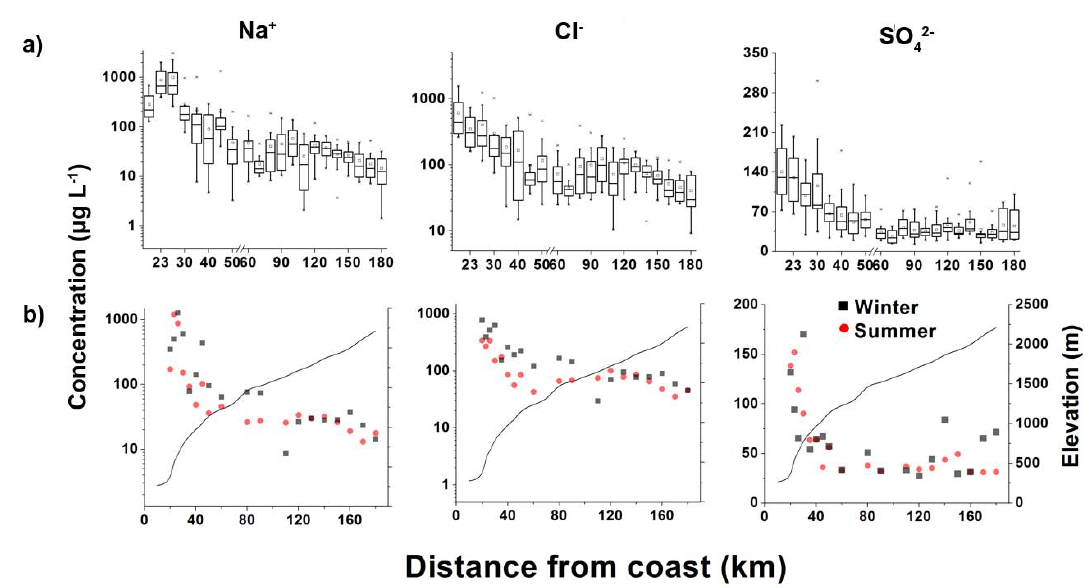
Fig. 3. (a) Spatial distribution and statistical variations in the annual concentrations of Na + , Cl − and SO 2 − logarithmic scale for concentrations in Na + and Cl − plots. The square and the line inside the box represent mean and median, respectively; the whiskers outside the box represent the upper (99%) and lower (1%) quartiles and “x” denotes the outliers. Breaks in the x-axis show difference in sampling interval before and after 50km. (b) The summer and winter concentrations of the respective sea-salt ions along with the elevation